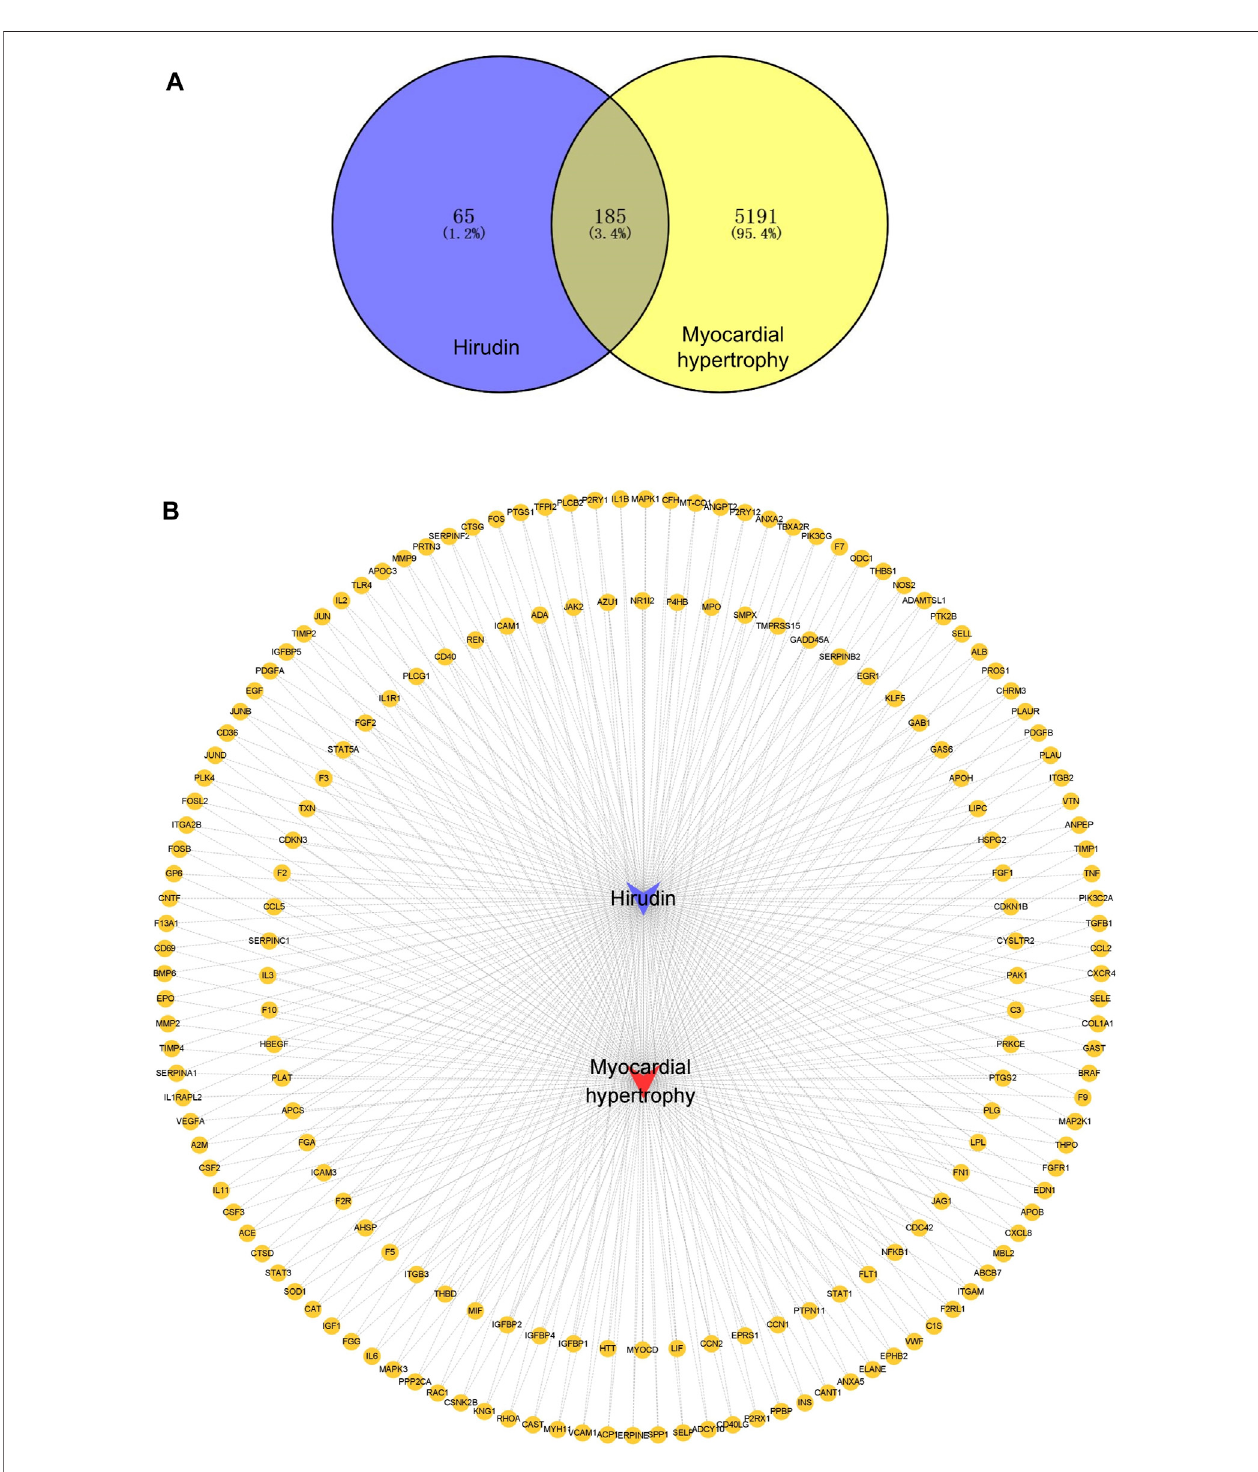
FIGURE2| Venndiagramofmyocardialhypertrophytargetsandhirudin targetsandtheirnetworkrelationships. (A) Venndiagramoftargets. (B) Networkdiagram of compound-target-disease, the yellow circles represent genes, the purple V shape represents hirudin and the red V shape represents myocardial hypertrophy.